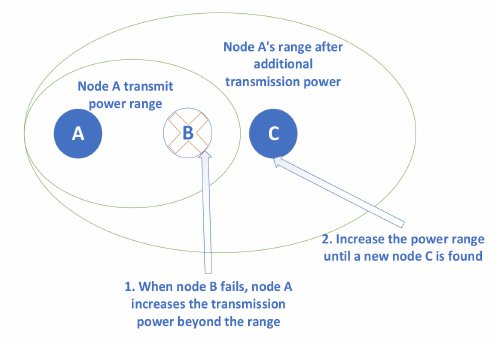
Figure 4. Power control